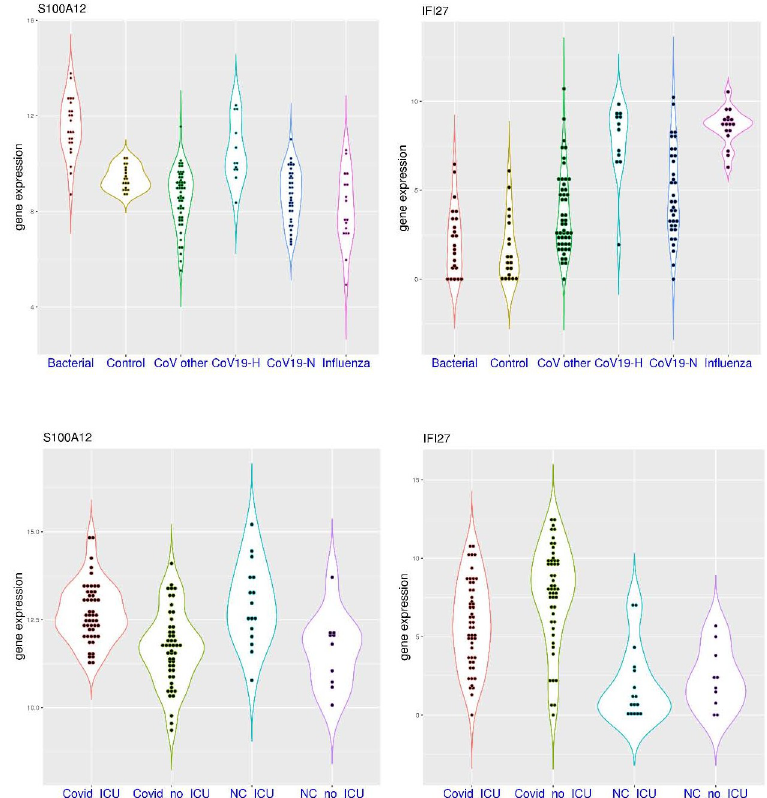
Fig 5. Expression level of S100A12 and IFI27 in COVID-19 patients and patients with other diseases (whole blood). A) upper panel (dataset GSE161731), comparison of S100A12 and IFI27 expression in healthy controls and patients with COVID-19 (hospitalized and non-hospitalized) or other types of infection. B) lower panel (dataset GSE157103), comparison of S100A12 and IFI27 expression in intensive care unit (ICU) and non-ICU patients with or without